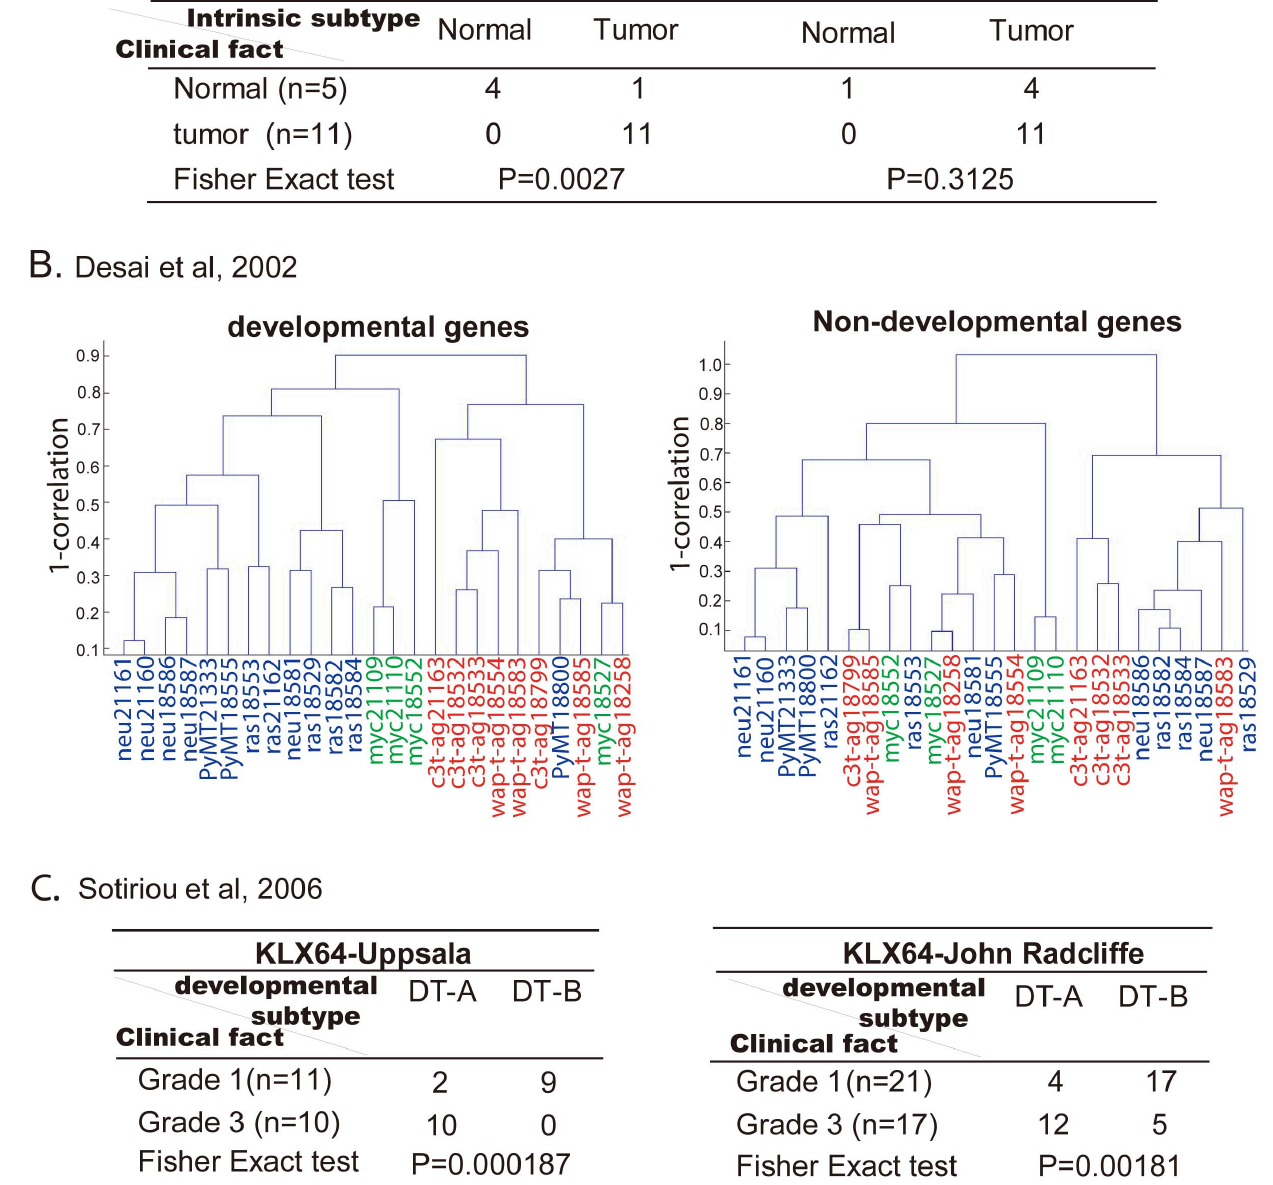
Figure 3.The expression profiles of mammary gland developmental genes in breast tumors reflect the characteristics of the tumors. Tumors samples include 5 normal tissues and 11 breast cancer samples ( A ), 25 mouse mammary gland tumors from six human oncogenic transgenetic mice ( B ), as well as two groups of grade 1 and grade 3 human breast tumors ( C ). Tumors were first classified based on the expression profiling of mammary gland developmentally associated genes by unsupervised classification with hierarchical clustering algorithm. Then, accuracy of classification was assessed with Fisher exact test. The non-developmental gene subset was included as a control.